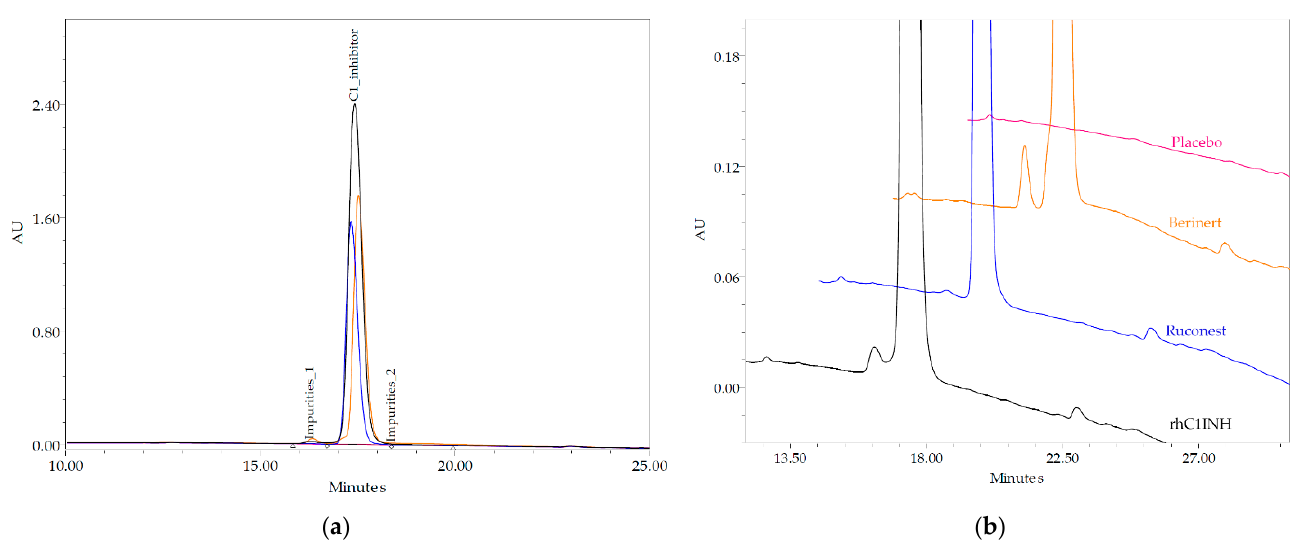
Figure 6. Comparison of reverse-phase chromatograms of the novel rhC1INH (black line), Berinert ® (yellow line), Ruconest ® (blue line) and placebo (red line); ( a ) full view of the chromatogram, ( b ) enlarged view of impurities peaks.